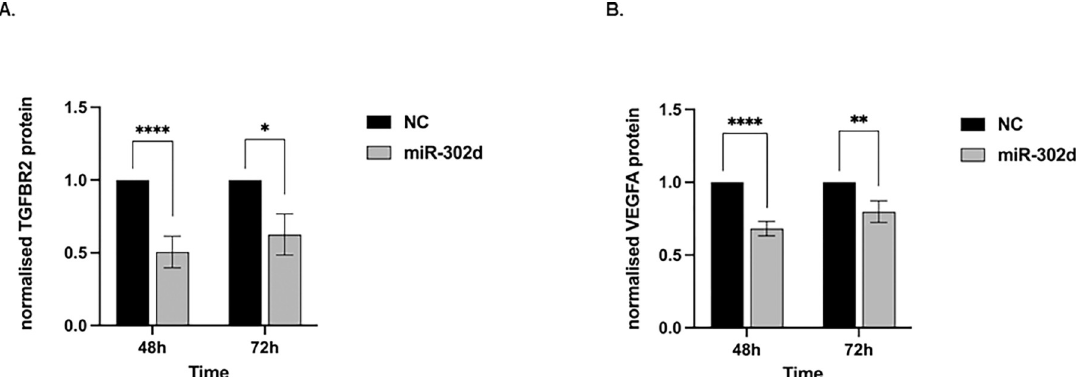
Fig 10. miR-302d downregulates TGFBR2 and constitutive secretion of VEGFA in hRPE cells. (A) ELISA for TGFBR2 protein levels 48 and 72 h after transfection with miR-302d relative to NC. The TGFBR2 protein was related to the total protein amounts determined by BCA assay. The amounts at 48 h were 10.35 ± 6.09 pg/mg in the NC group and 5.44 ± 3.49 pg/mg in the miR-302d group. The amounts at 72 h were 10.79 ± 4.31 in the NC group and 6.92 ± 3.45 in the miR-302d group. The values were further normalized to the NC group. (B) ELISA for secreted VEGFA protein levels 48 and 72 h after transfection with miR-302d relative to NC. The concentrations at 48 h were 423.93 ± 26.18 pg/ml in the NC group and 288.79 ± 26.18 pg/ml in the miR-302d group. The concentrations at 72 h were 658.87 ± 48.11 pg/ml in the NC group and 523.93 ± 44.09 pg/ml in the miR-302d group. The values were further normalized to the NC group. Unpaired two-tailed t-tests (n = 3) were performed. The error bars represent SD. ns, non-significant, � p < 0.05, �� p < 0.01, ���� p <